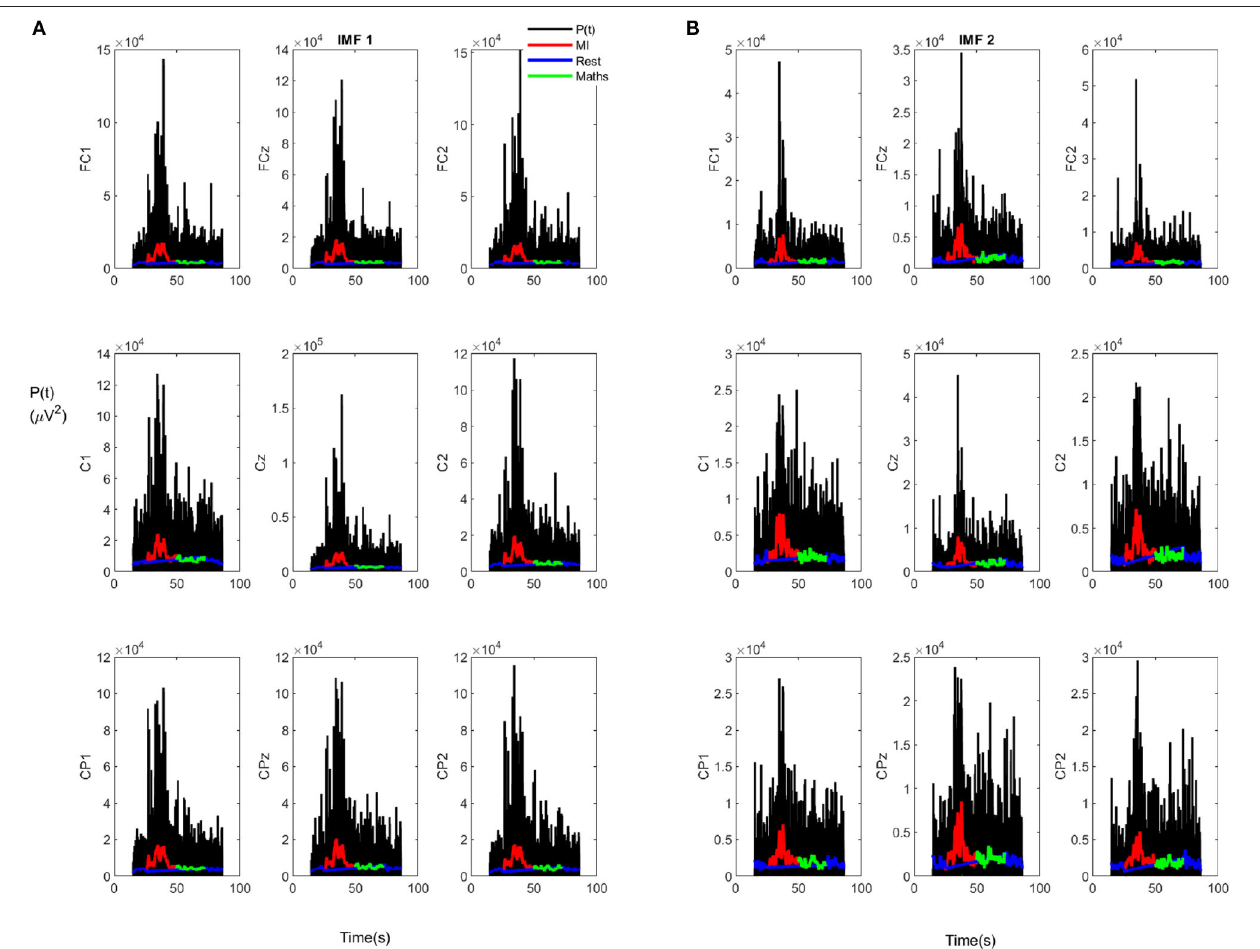
FIGURE 7 | Evolution of the instantaneous power for trial 1 of subject S2: (A) IMF1. (B) IMF2.